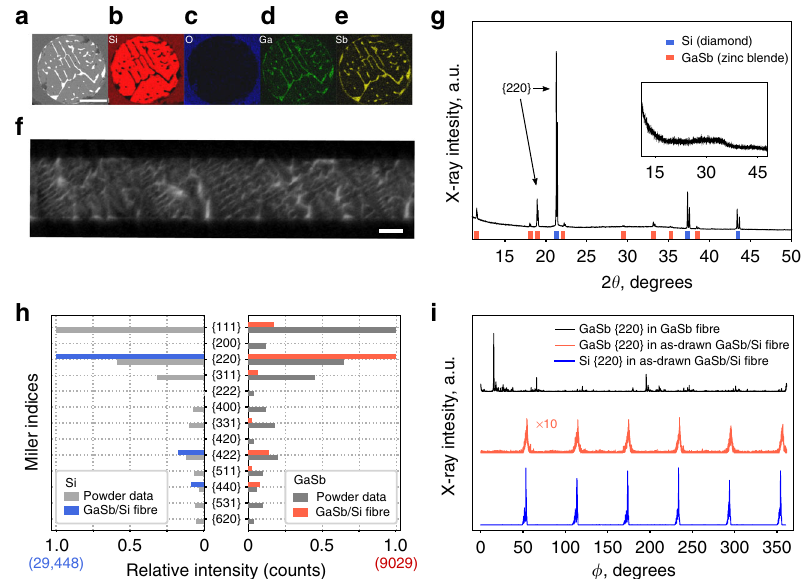
Fig. 1 Structural information for an as-drawn composite GaSb/Si fi bre. Cross-sectional SEM images of the core; a BSE image, and b Si, c O, d Ga and e Sb EDX maps showing pseudo-eutectic microstructure (scale bar, 50 µ m). f X-ray computed tomography image of the fi bre (scale bar, 50 µ m). g X-ray diffraction acquired with fi bre rotating around its axis; inset is from a fi bre with no core. h Relative Bragg intensities observed for silicon and GaSb planes in the composite fi bres compared to powder spectra (count number for highest fi bre XRD peak in parentheses), and i comparison of variation in intensities of the {220} Bragg peaks, during rotation, for a pure GaSb fi bre (black), and the GaSb (orange) and silicon (blue) {220} re fl ections in the composite fi bre. Pure GaSb fi bres show many re fl ections, indicating